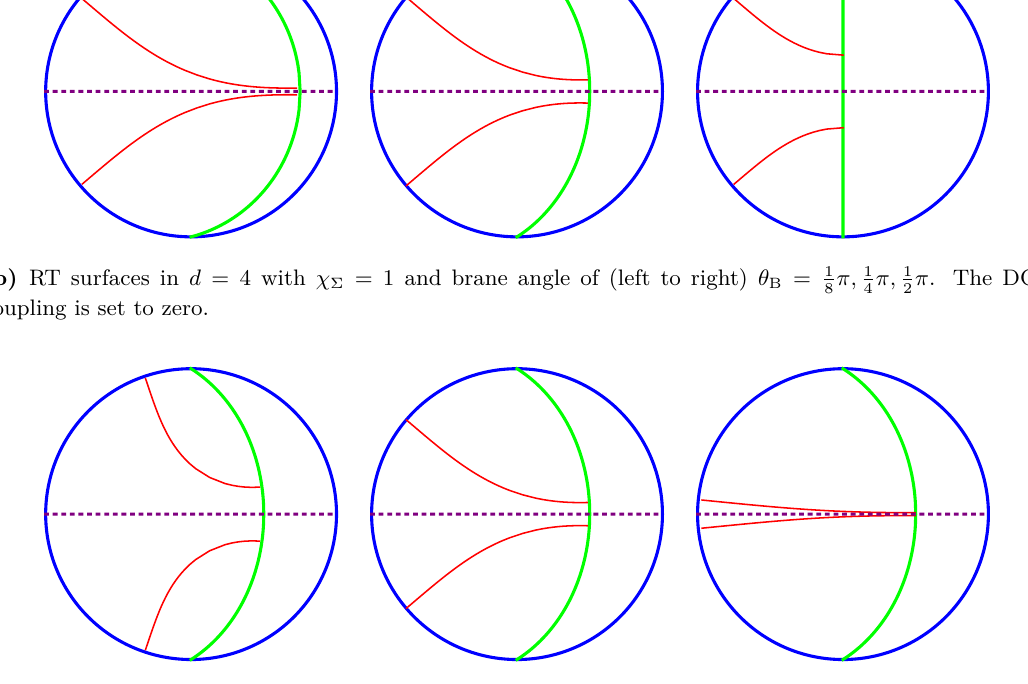
Figure 14. RT surfaces in the island phase in higher dimensions. We only show one side of the brane. The asymptotic boundary of the spacetime is shown in blue, the Planck brane in green and the RT surfaces in red. The radial coordinate is % defined in eq. (4.1). On each side of the horizon (dashed purple line) the angular coordinate ξ runs between − π